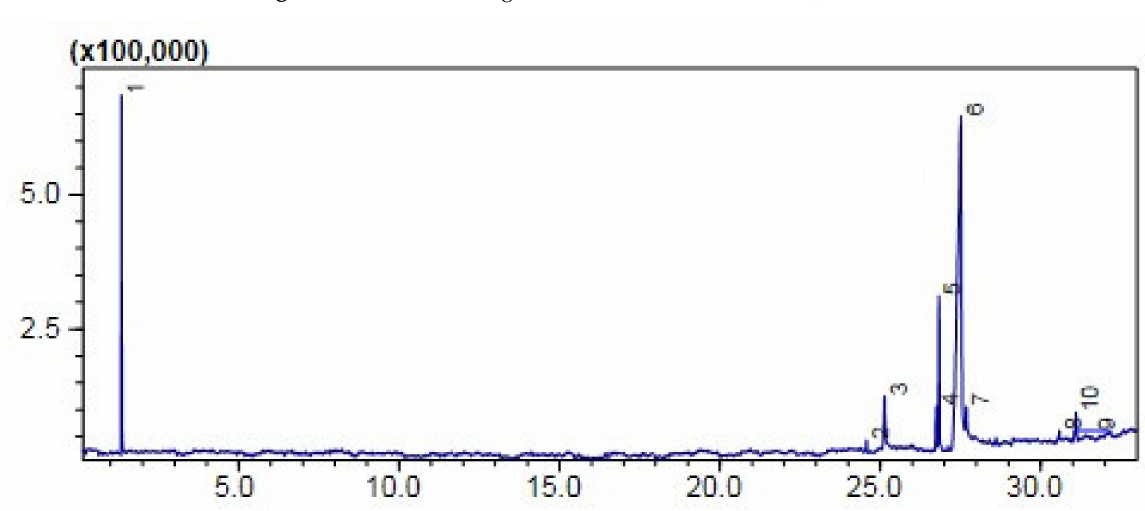
Figure 12. GC Chromatogram of PAOB treated with TiO 2 .